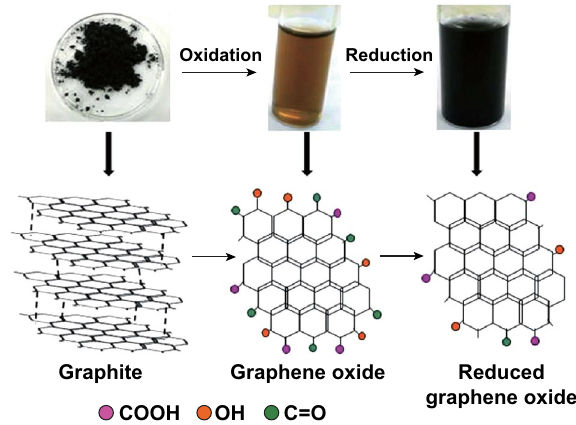
Fig. 1 Process of graphene synthesis. Graphite is exfoliated and oxi- dized to form hydrophilic graphene oxide (brown solution). Graphene oxide is further reduced to obtain reduced graphene oxide, which is less stable in water (black